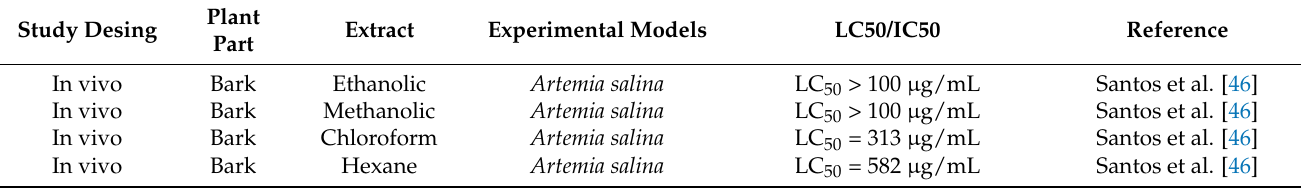
Table 6. Toxicity tests of S. brasiliensis extract against different experimental